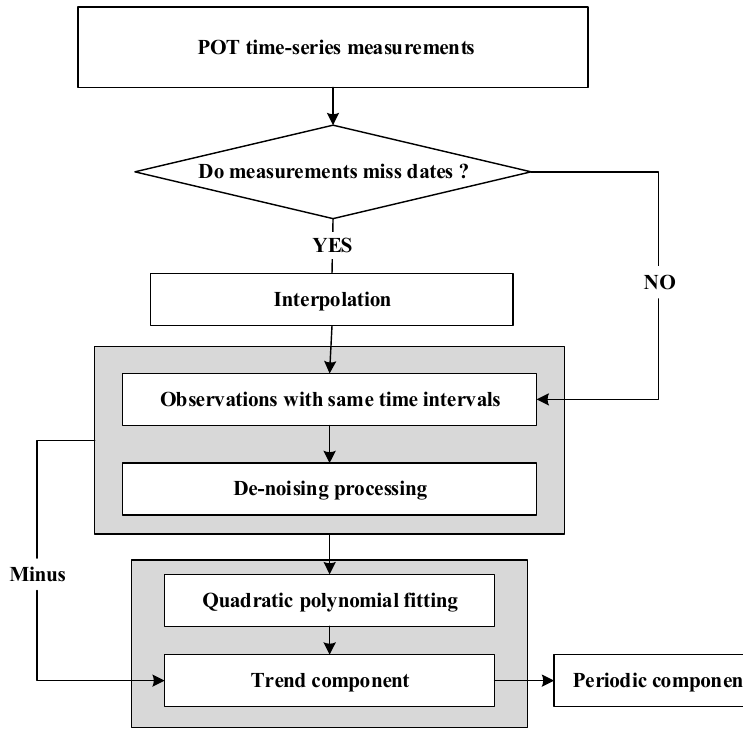
Figure 2. The flow chart for time series decomposition.